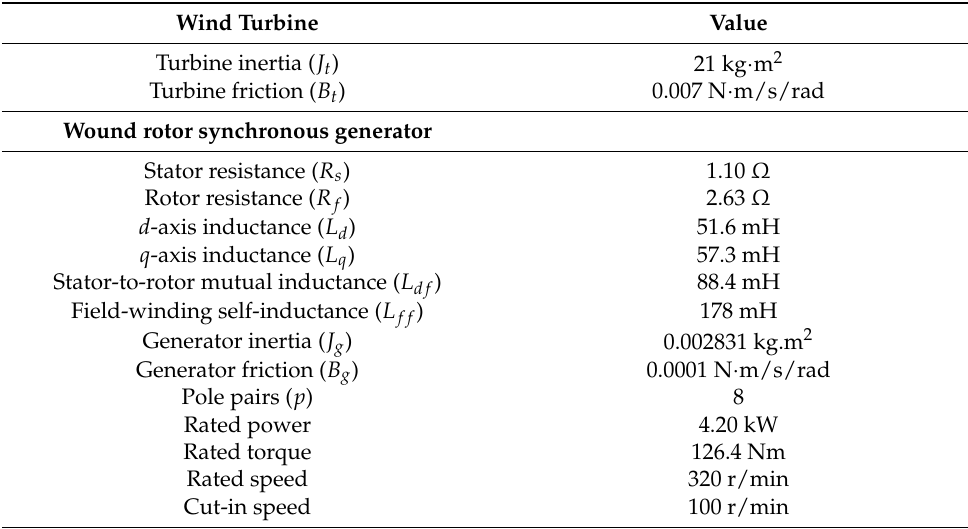
Table A1. Matlab/Simulink simulation